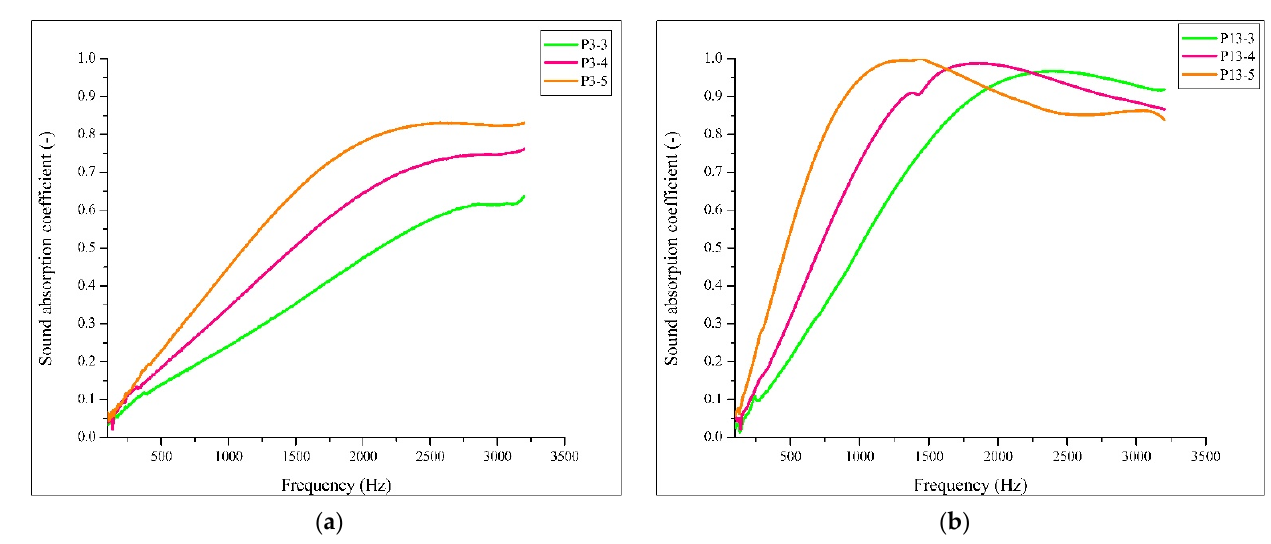
Figure 19. Sound absorption curves of samples: ( a ) P3 (wool–latex) with thicknesses of 3, 4 and 5 cm; ( b ) P13 (wool–resin) with thicknesses of 3, 4 and 5 cm. Table 5. Maximum sound absorption coefficient ( α max ), frequency corresponding to the maximum sound absorption, and the noise reduction coefficient (NRC) for the tested